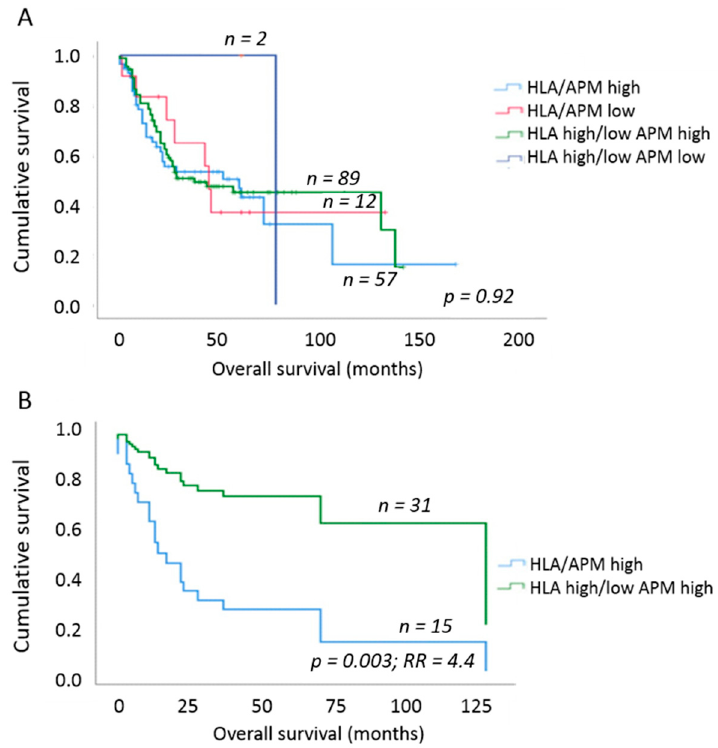
Figure 3. Overall survival of OSCC patients depending on HLA-I/APM phenotype. ( A ) Comparison